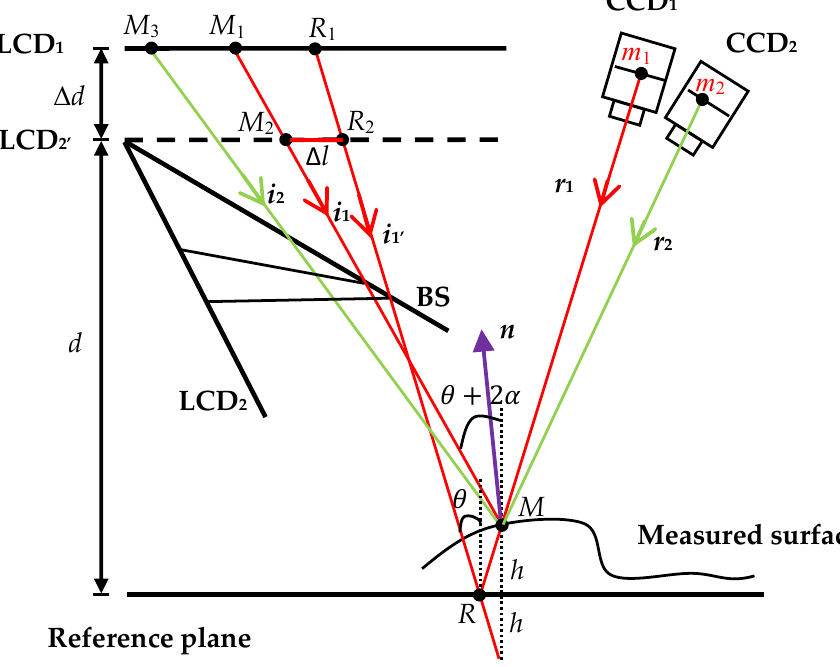
Figure 3. Mathematical model.